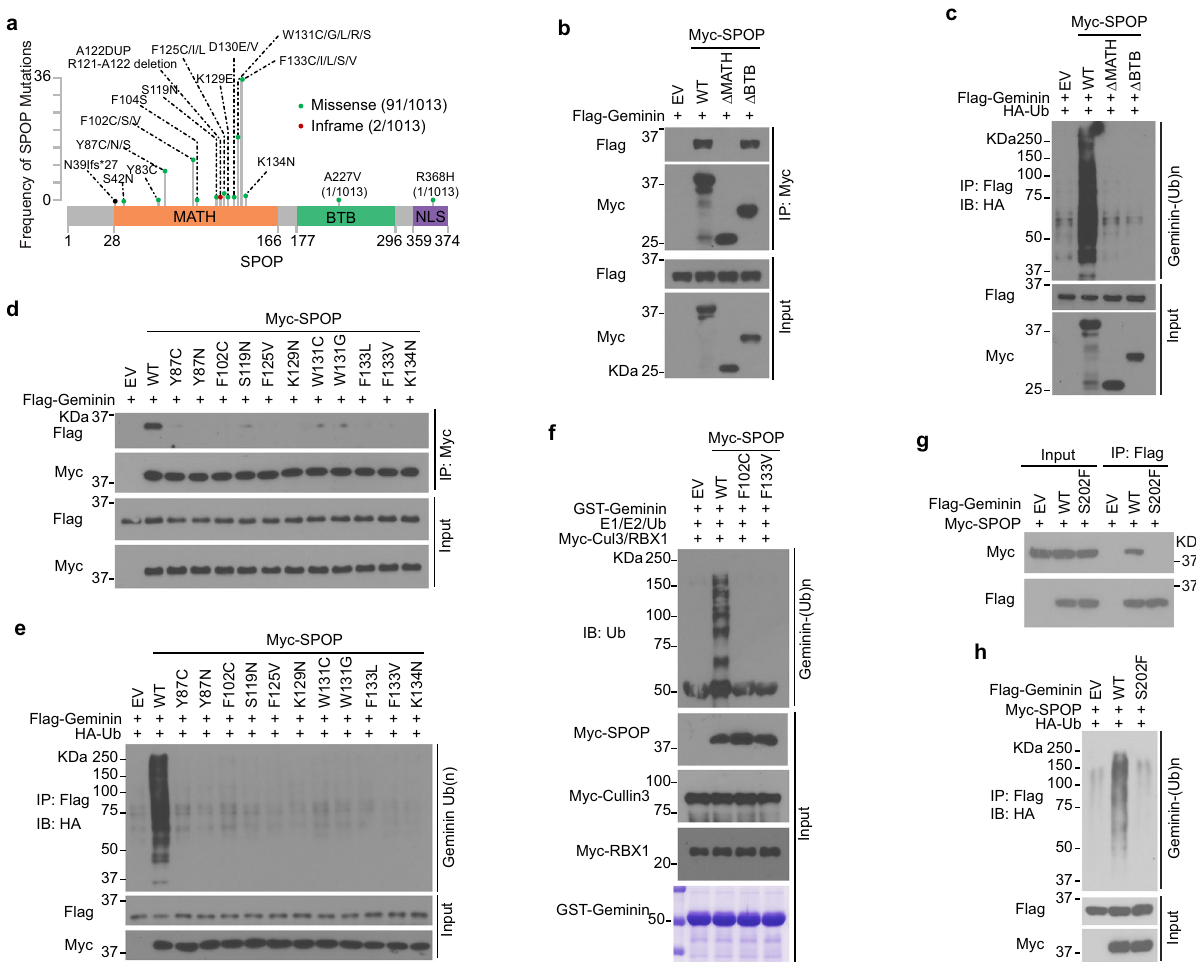
Fig. 3 Prostate cancer-derived SPOP mutants fail to promote Geminin poly-ubiquitination. a Schematic of domain organization of SPOP and SPOP mutations detected in 1013 cases of prostate cancers 30 . b 293T cells transfected with Flag-Geminin in combination with empty vector (EV), SPOP WT, or mutants were harvested for co-IP and WB with indicated antibodies. c 293T cells were transfected with the indicated plasmids and harvested for IP to detect the ubiquitination of Geminin. d 293T cells were co-transfected with Flag-Geminin and SPOP WT or mutants and harvested for co-IP and WB. e 293T cells were co-transfected with Flag-Geminin and SPOP WT or mutants and harvested for co-IP and WB to detect Geminin poly-ubiquitination. f In vitro ubiquitination assay was performed by incubating the reconstituted E1 and E2 enzymes with CUL3/RBX1, Myc-SPOP WT, or mutants immunoprecipitated from 293T cells and GST-Geminin puri fi ed from E. coli . g , h Co-IP analysis of indicated proteins and ubiquitination in 293T cells transiently transfected with Flag-Geminin-WT or S202F mutant. Source data are provided in this paper or Mendeley database (10.17632/8n7xt5rkhc.1). Similar results for ( b – h ) panels were obtained in two independent to eliminate any steric clash. Our structural model for Geminin- MCM complex. Despite low sequence similarities, Cdt1 from bound OCCM (Fig. 4c) predicts that K27-linked poly-ubiquitina- human (hCdt1) and yeast (yCdt1) both have conserved winged- helix domains (WHD) in their middle (M-WHD) and C-terminal (C-WHD) regions (Supplementary Fig. 3f) 48 . Because of these ubiquitination of Geminin affects the Cdt1-MCM interaction, structure of the Geminin-bound M-WHD region of hCdt1 (PDB while not directly affecting the Geminin-Cdt1 interaction. In 2WVR) 26 to replace the corresponding yCdt1 region in the agreement with our model in Fig. 4c, co-IP and mass spectro- aforementioned OCCM intermediate complex (PDB 6WGG) 47 . metry assays showed that Geminin could pull down MCM proteins and that SPOP-mediated poly-ubiquitination of Gemi- nin reduced Geminin-MCM complex formation (Supplementary Fig. 3i – k). In addition, in vitro translated MCM2 protein showed no direct binding to GST-Geminin puri fi ed from bacteria (Supplementary Fig. 3l), indicating that Geminin indirectly associates with MCM proteins. We further performed fl uorescence-activated cell sorting (FACS) analysis to determine the effect of SPOP ubiquitination of Geminin on cell re-replication. Geminin knockdown increased